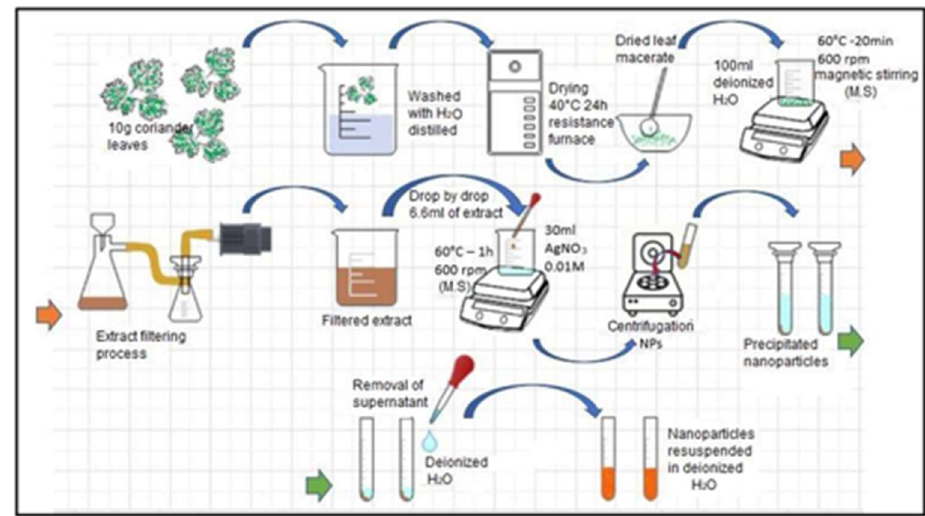
Figure 3. Precedence diagram illustrating the complete process of AgNP synthesis.